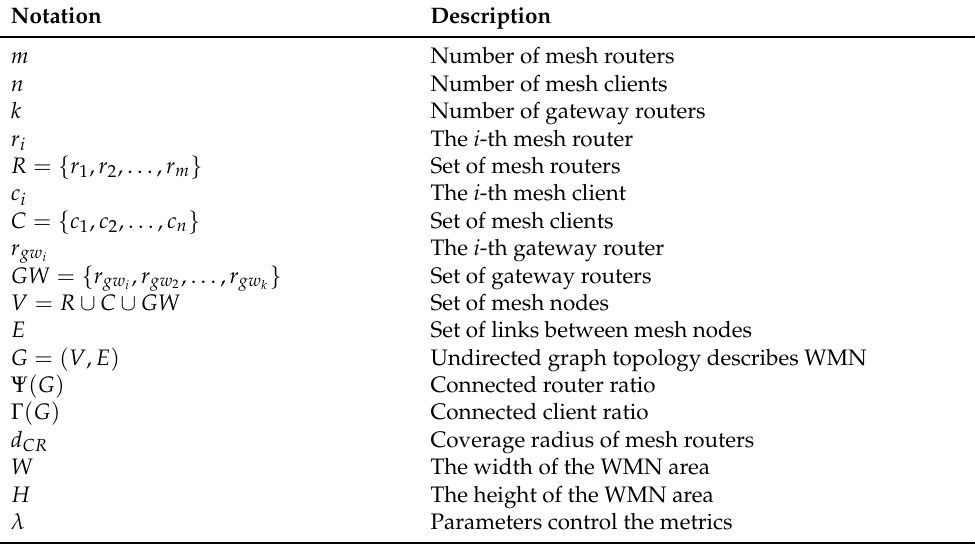
Table 1. The notation used for formulating the node placement problem in the